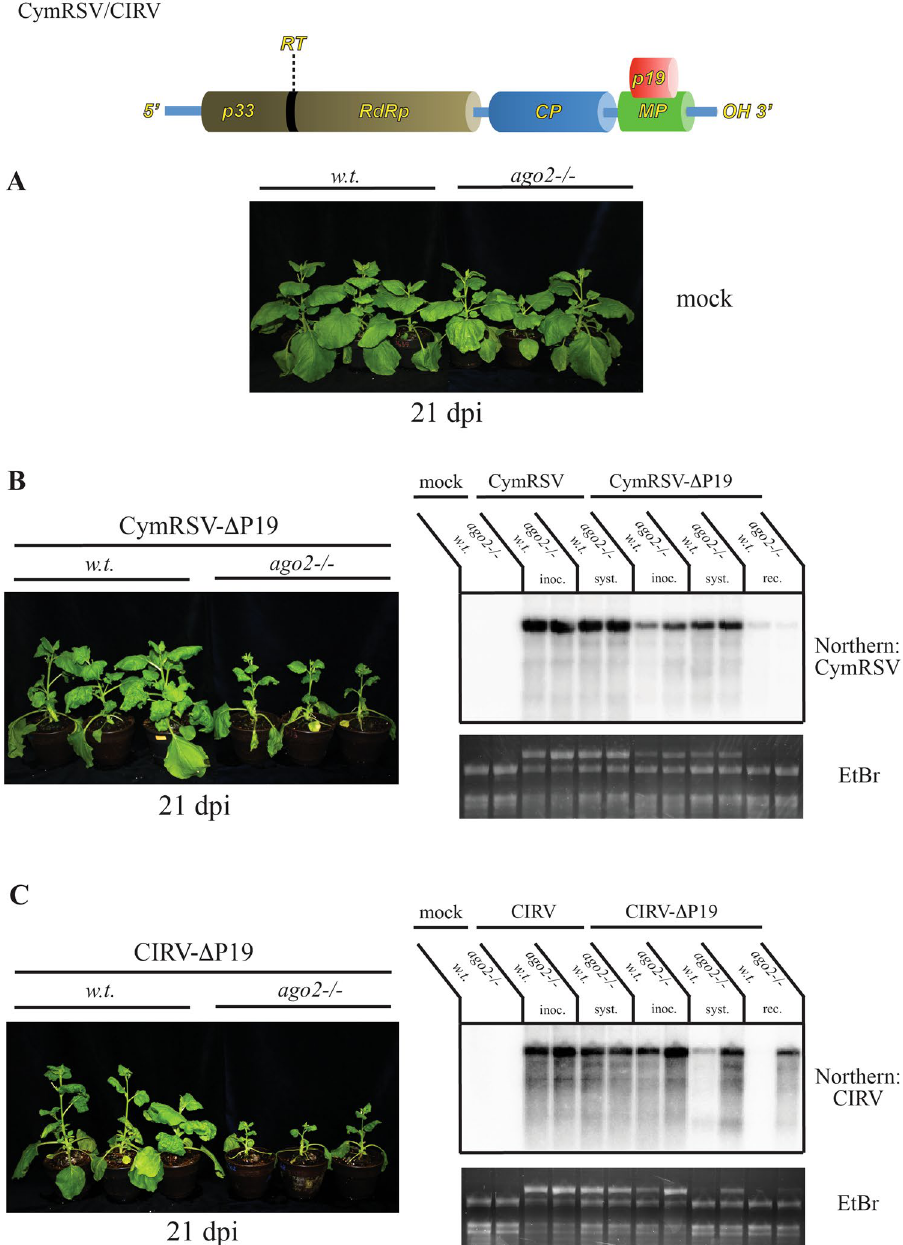
Figure 5. Effect of AGO2 on tombusvirus infection. Wild-type and ago2 N. benthamiana plants were infected with in vitro transcribed wild-type and Δ P19 mutant CymRSV ( B ) and CIRV ( C ) viral transcripts. Mock infections were also performed ( A ). At 5 dpi, total RNA was prepared from the inoculated and the first symptomatic non-inoculated leaves. RNA samples were purified from recovered apical leaves at 21 dpi. Samples were collected from three plants and pooled. Viral gRNA accumulation was monitored by northern blot. Ethidium-bromide stained gels are shown as loading controls. Photographs of virus infected and mock infected N. benthamiana plants are also shown at 21